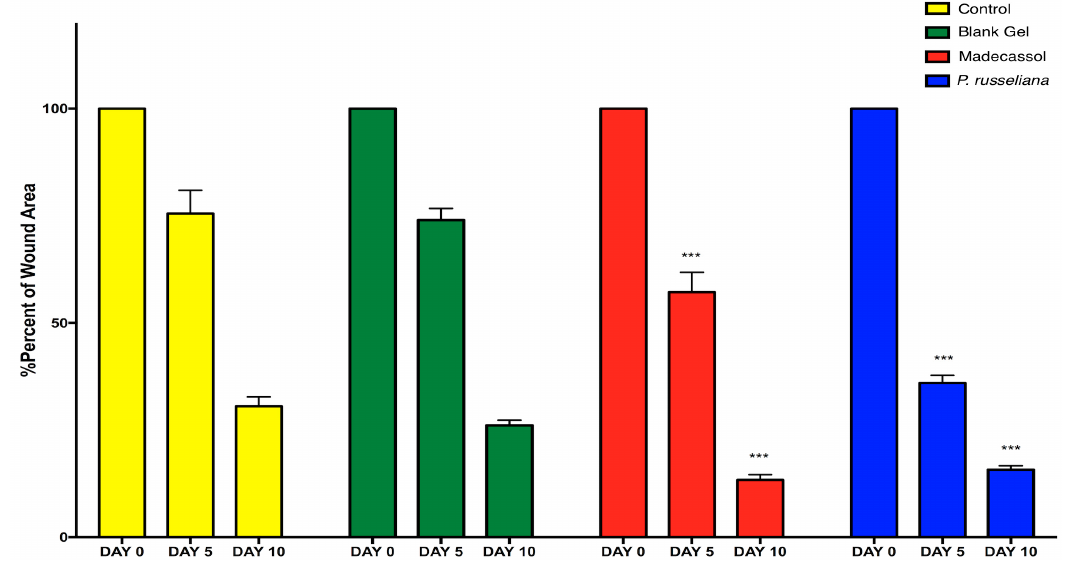
Figure 5. Healing percentages of the wound area in each test group (control, blank gel, Madecassol, P. russeliana extract gel). Statistically significant, compared to control groups; *** p < 0.001.